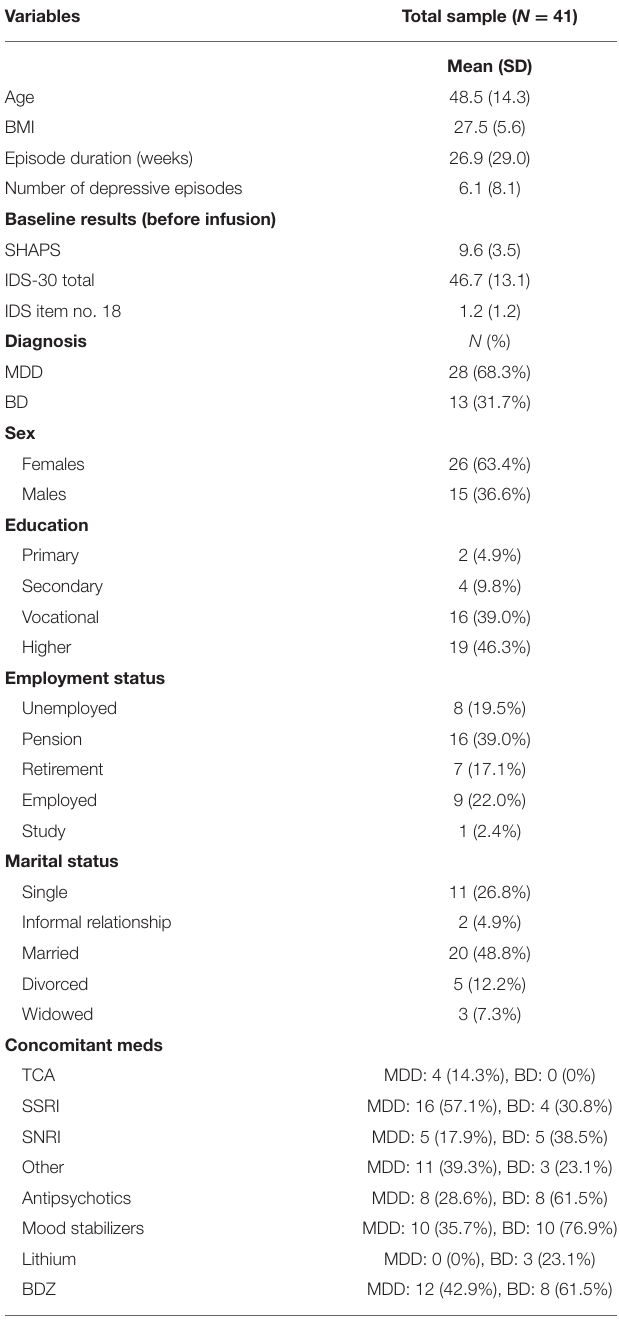
TABLE 1 | Demographic and clinical characteristics of the total sample.